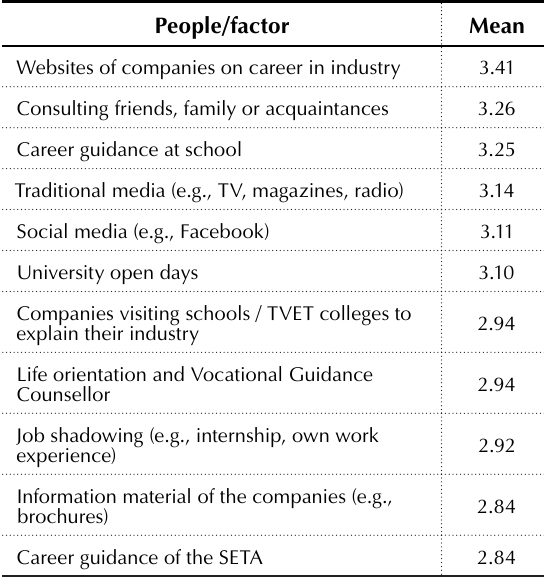
Table 4. Role of various information sources for